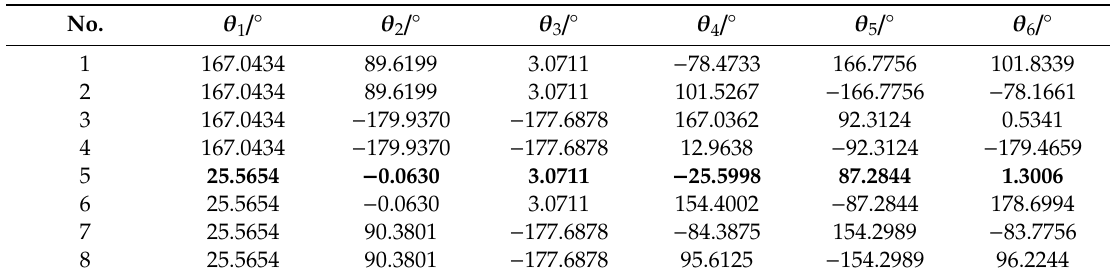
Table 17. Eight inversely solved joint angle sets.